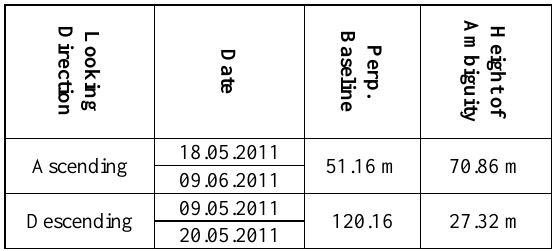
Table 1. Acquisition parameters of the TerraSAR-X imagery.